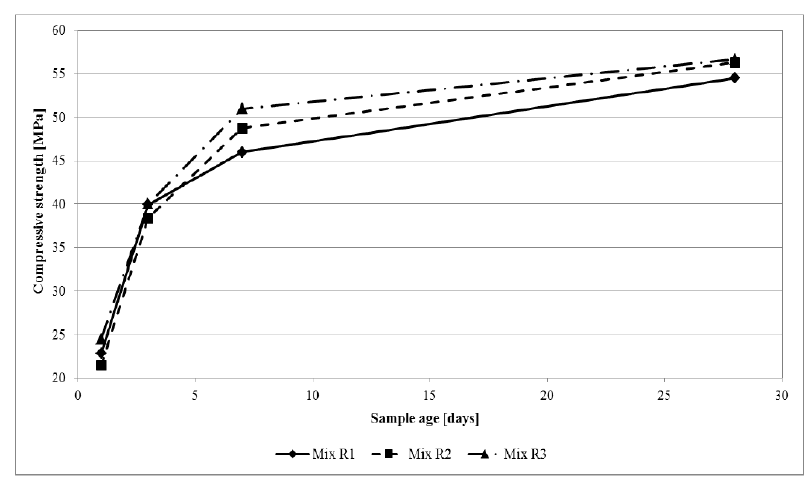
Figure 4. Graph of the increase in compressive strength at the end of the beams.